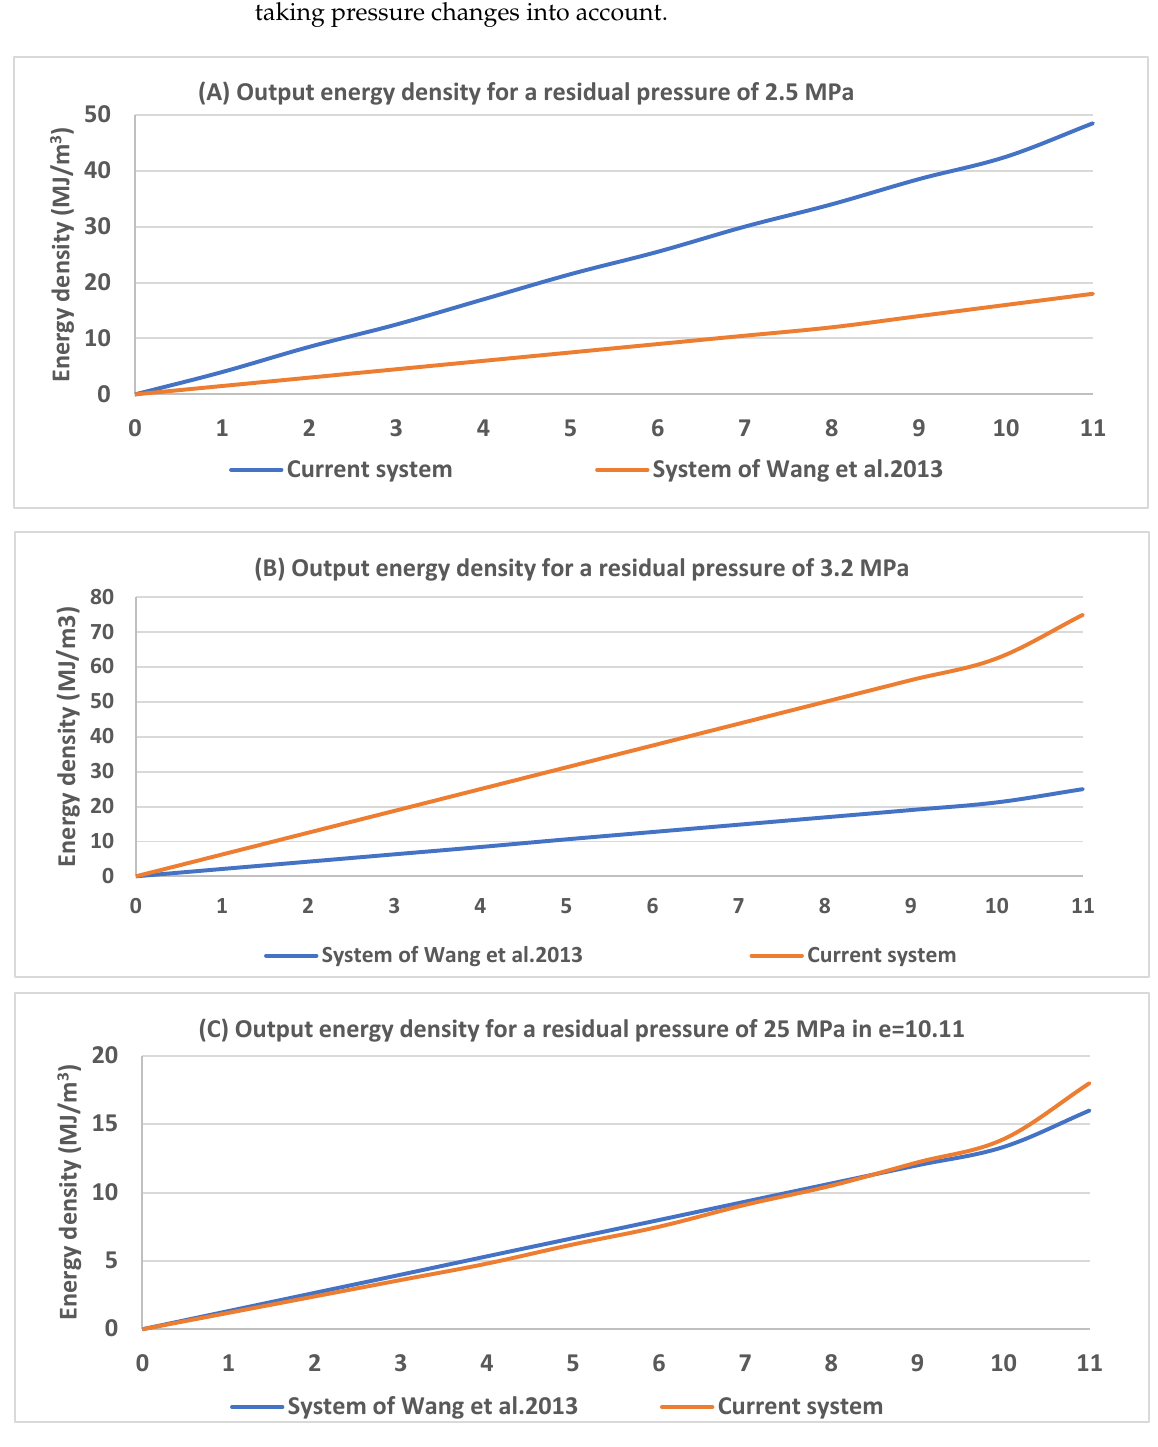
Figure 5. Changes in output energy density for a residual pressure of: ( A ) 2.5 MPa; ( B ) 3.2 MPa and; ( C ) 25MPa compared to 𝜖 under pressure conditions.